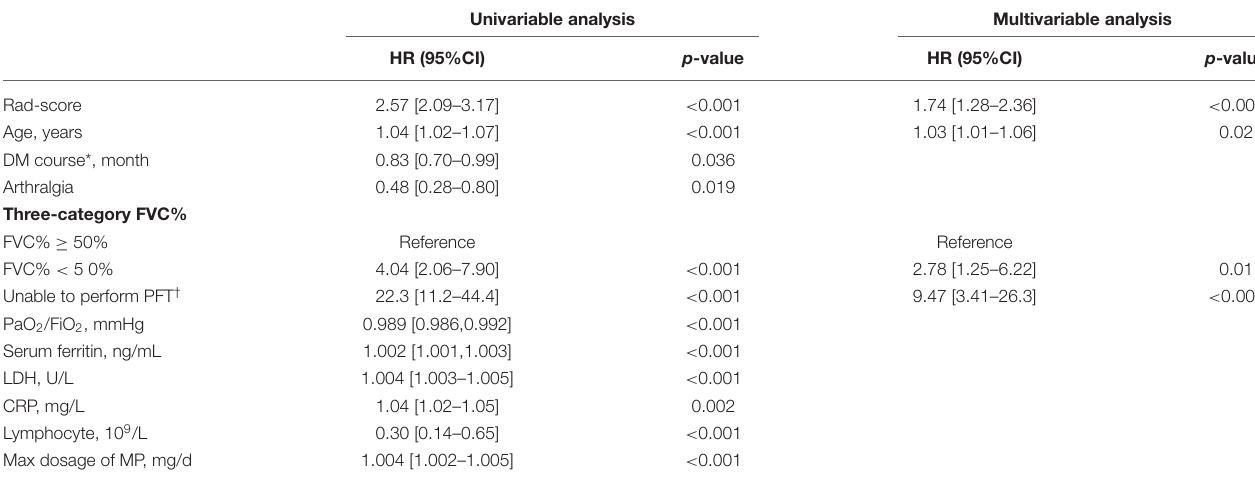
TABLE 3 | Results of univariable and multivariable Cox regression.